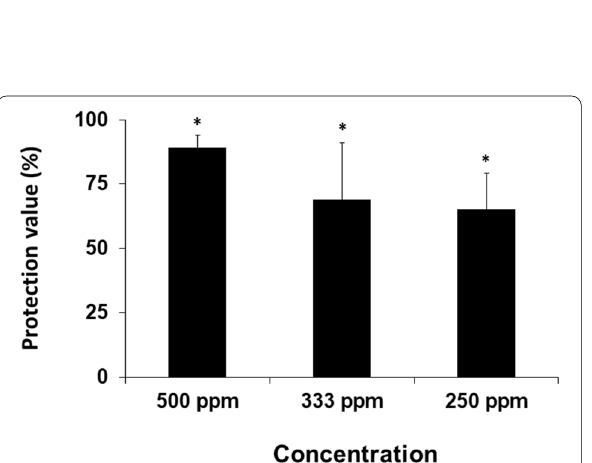
Fig. 2 Antiviral activities of purified A. zerumbet extracts against GFP-tagged ToMV virions. Nicotiana benthamiana plants were treated with water (control) and different concentrations (250 ppm to 500 ppm) of purified samples from the aqueous extract of A. zerumbet , and then inoculated with GFP-tagged ToMV at three days post treatment. The GFP spots formed on the inoculated leaves were counted at 3 dpi. Protecting value (%) (1 number of GFP spots on = − the treated plants/number of GFP spots on the control plants) 100. × Asterisks indicate significant differences between the control and treated plants at each leaf position by one-way ANOVA with the Tukey–Kramer method ( p <